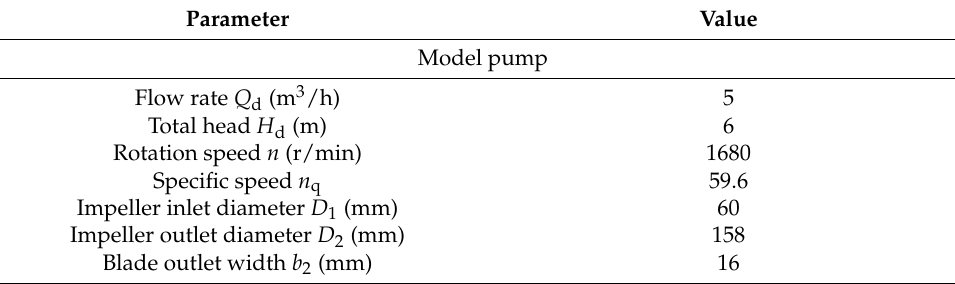
Table 1. Parameters of the test pump and high-speed